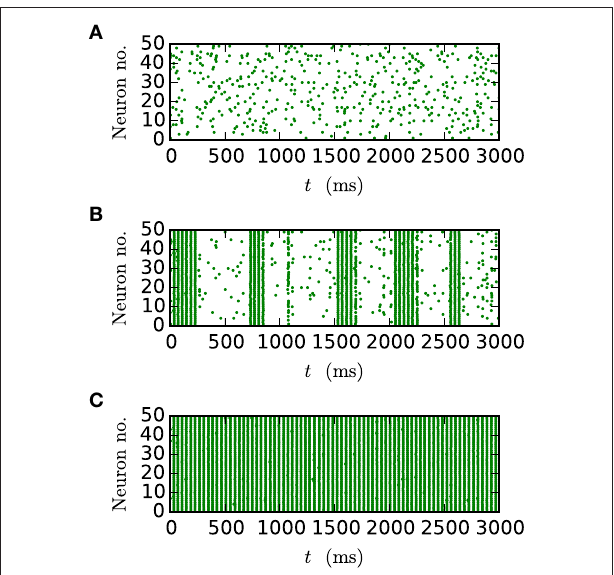
FIGURE 9 | Spike patterns for different gap weights. The panels show the spike times of the first 50 neurons of the inhibitory network described in Section 2.3 (Test case 2) over 3 s of biological time for J I = − 25 pA . All results were obtained with the iterative method with cubic interpolation and step